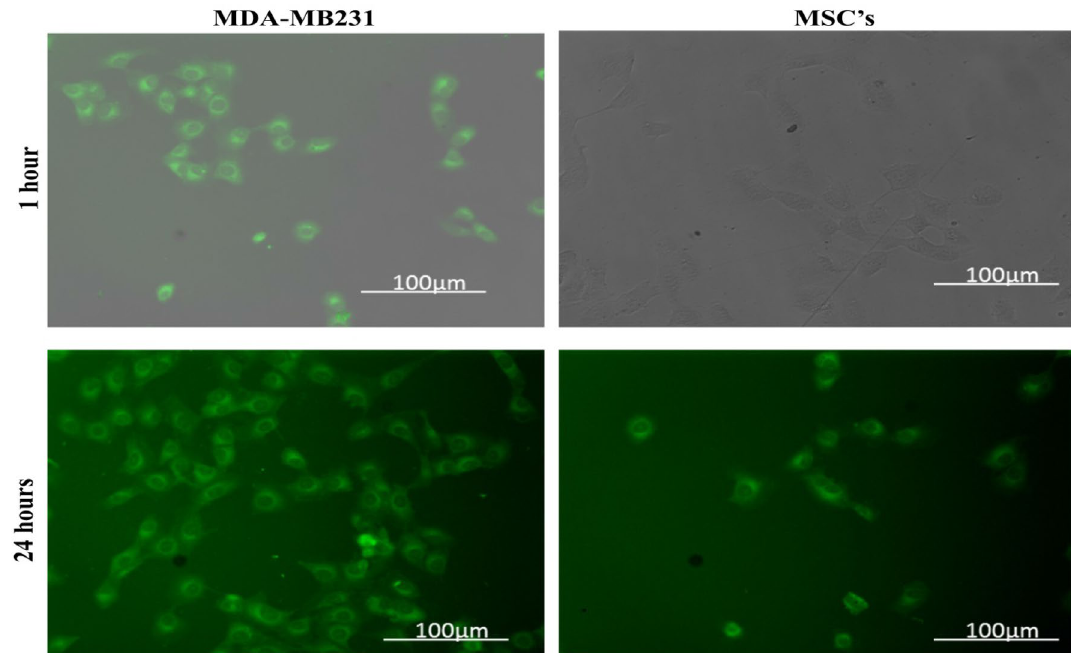
Figure 8. Cellular uptake of NC-virosome in MDA-MB231 and MSC’s cells through a fluorescence microscope (objective lens 60×) at different time points (1 and 24 h).